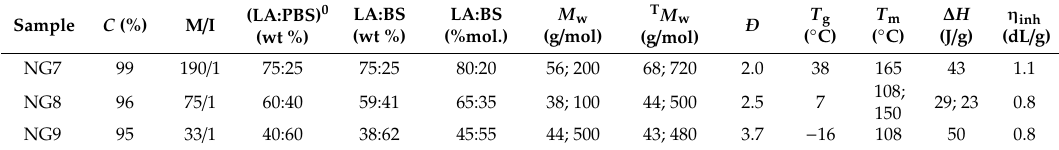
Polymerization carried out in bulk at 120 °C for 120 h, catalyst Zr(acac) 4 at a monomer/catalyst molar ratio as 1000/1, where: C — L -lactide conversion, M/I—monomer to initiator molar ratio (macroinitiator NG 6, poly(butylene succinate) with M n about 7000 g/mol), (LA:PBS) 0 —weight ratio of L -lactide to poly(butylene succinate) in started reaction mixture, LA:BS—weight (and molar) ratio of lactidyl units to butylene succinate units in the copolymers chain, M w —weight average molecular mass of the copolymer determined in GPC measurements, T M w —calculated theoretical average molecular weight of the copolymer, Đ —molecular weight dispersion determined in GPC measurements, T g —glass transition temperature, T m —temperature of melting of the crystalline Table 2. Properties of obtained poly( l -lactide)– block –poly(butylene succinate) copolymers. phase, Δ H —enthalpy of melting of the crystalline phase, η inh —inherent viscosity of the copolymer in chloroform solution.